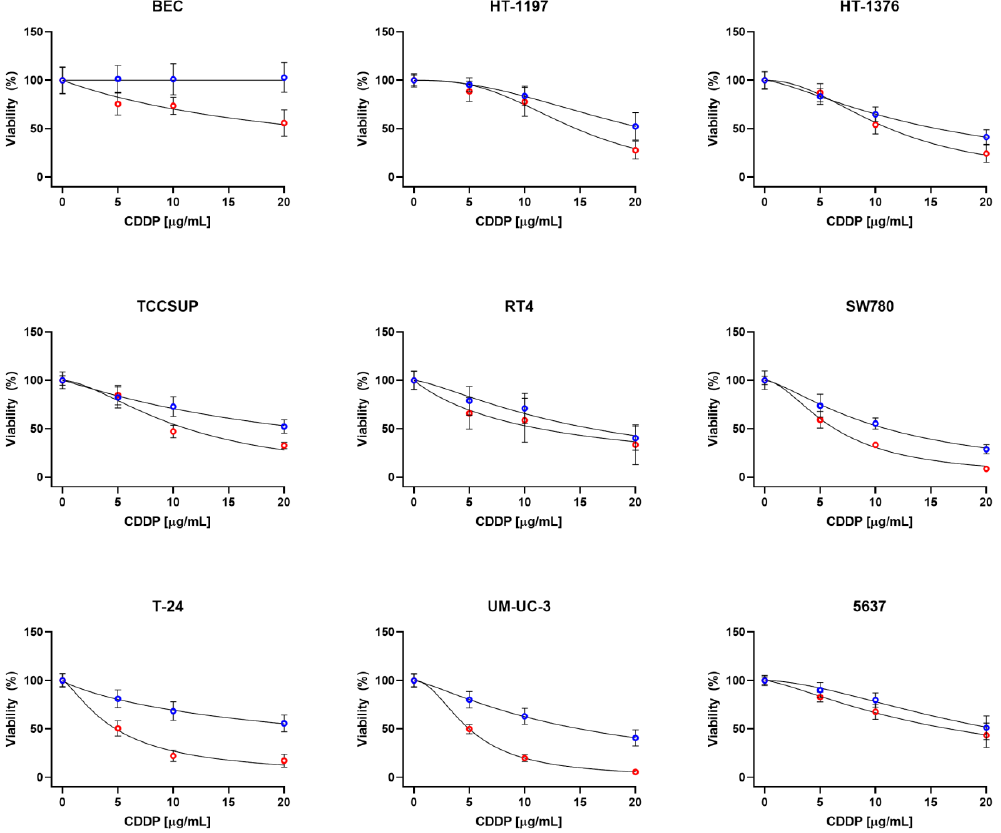
Figure 1. Viability of the UCC lines and BEC after 2 h CDDP exposure followed by 24 (blue) and 48 (red) h post-incubation under standard growth conditions. Values are shown as the mean ± SD ( n = 8 of three biological replicates). Table 1. IC 50 values for the UCC lines and BEC for all CDDP treatment conditions. CDDP, cisplatin; CI, confidence interval; NA, not